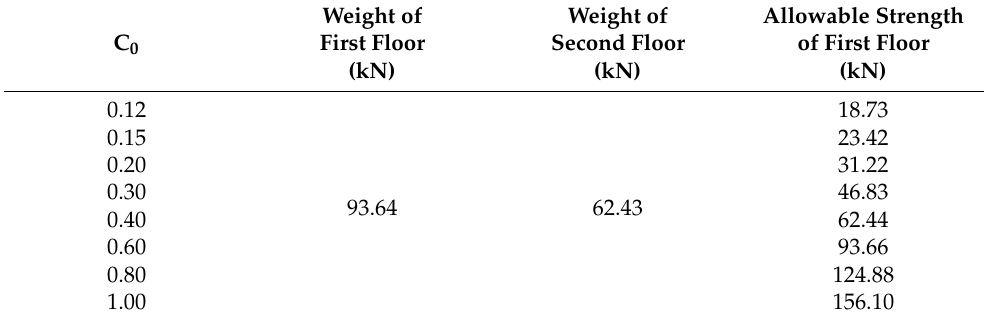
Table 5. Analysis